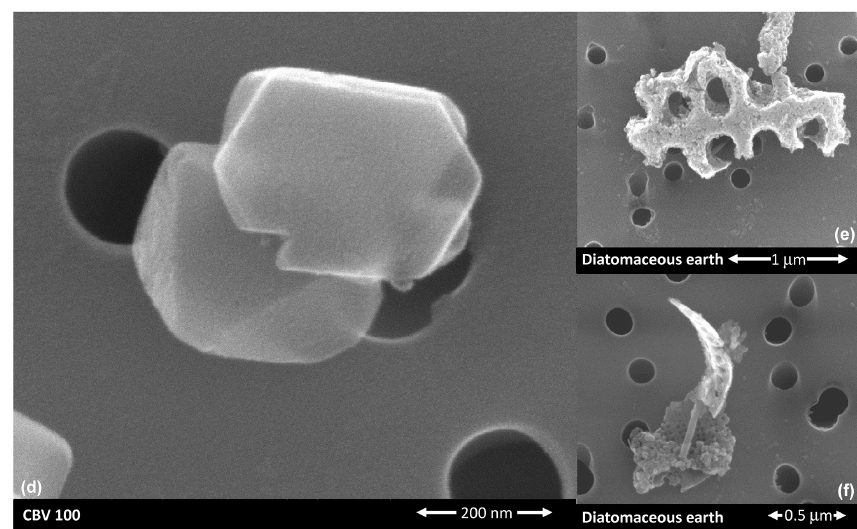
Figure 2. ESEM images of filter-collected zeolite CBV100 (d) and diatomaceous earth particles (e, f)